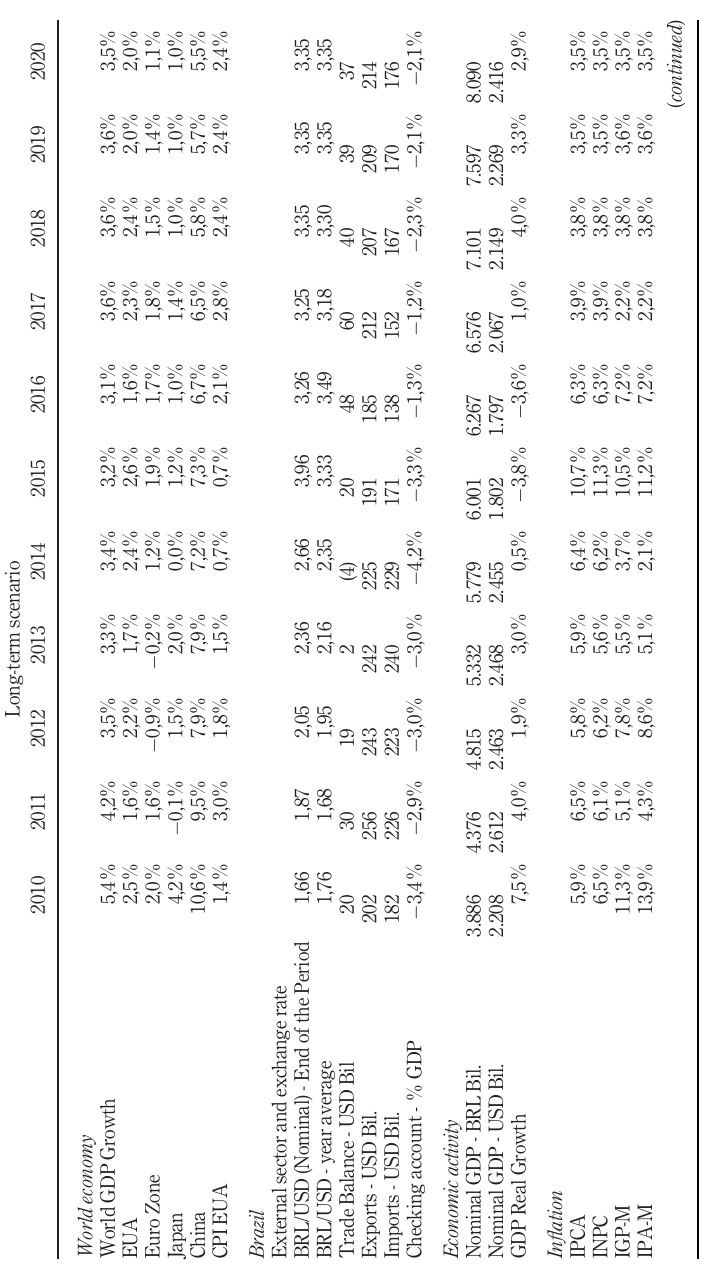
Table AII. Banco itaú long-term macroeconomic projections for